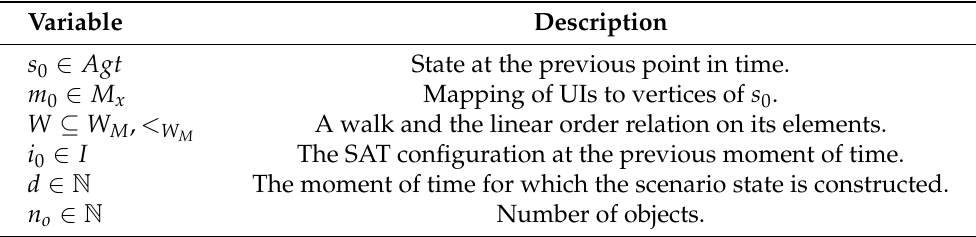
Table 7. Input data for the Phase 3 algorithm.